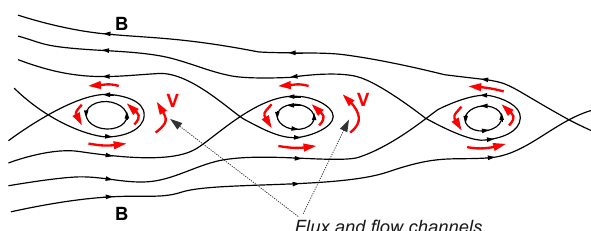
Fig. 6. Schematic drawing for positive Wal´en slope, showing chan- nels of inter-connected field and flow, located between magnetic is- lands and also field-aligned flow within the islands. Note that on the left side of each island the normal field and flow both point down- ward, while on the right side they both point upward. The flow along the intervening narrow channels that magnetically connect the two sides of the directional discontinuity (DD) is upward in the figure, a situation that corresponds to downward propagation relative to the plasma. However, unless it can be established that the observing spacecraft was in fact located in such a channel during its crossing of the structured DD, the overall direction of propagation of the DD cannot be established, even if B n and v n are well